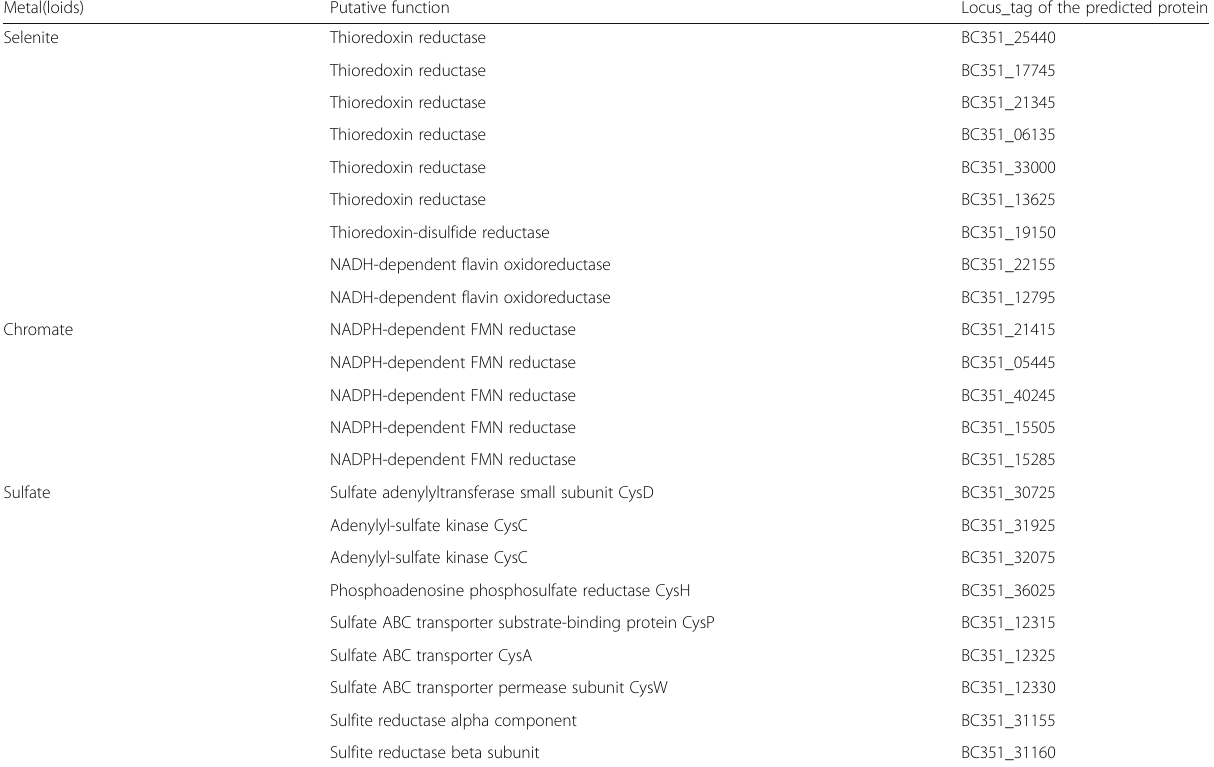
Table 5 Putative proteins involved in selenite, chromate and sulfate reduction Metal(loids) Putative function Locus_tag of the predicted protein Selenite Thioredoxin